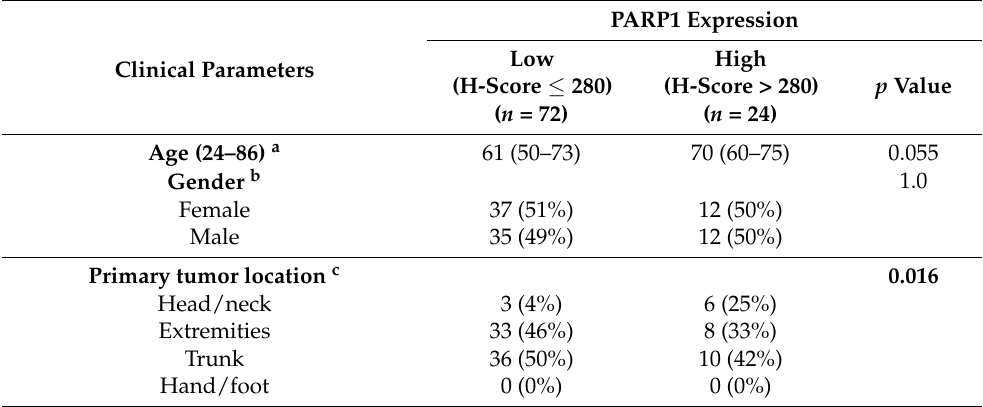
Table 4. Correlations between PARP1 expression and clinical parameters of cutaneous melanoma patients without lymph node